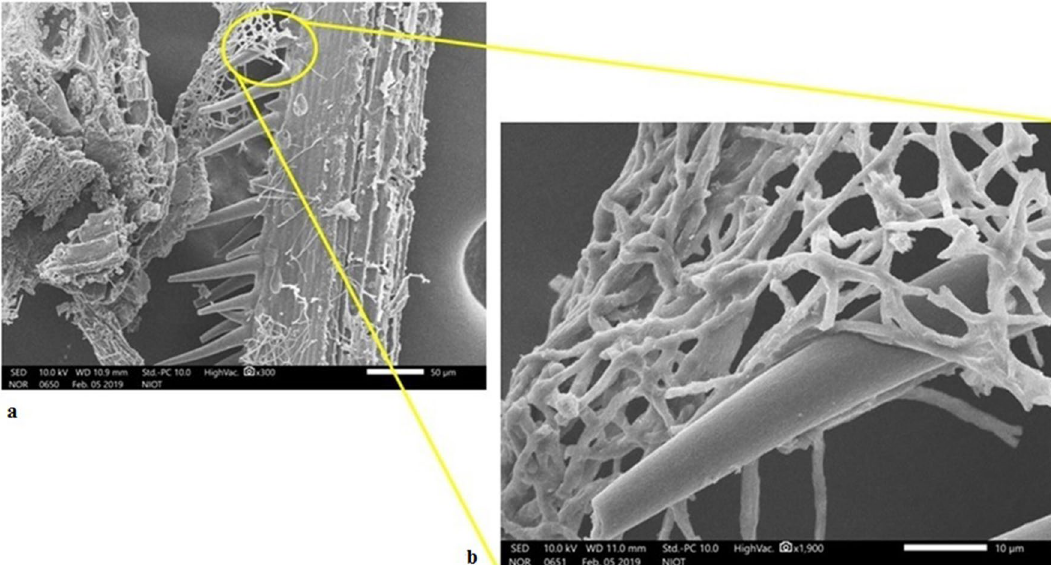
Figure 1. SEM image of immobilized A. sydowii BOBA1 ( a ). Dense mycelium with developed mass branching adhered to lignocellulose matrix ( b ). Enlarged image of the mycelial adherence on rice bran.